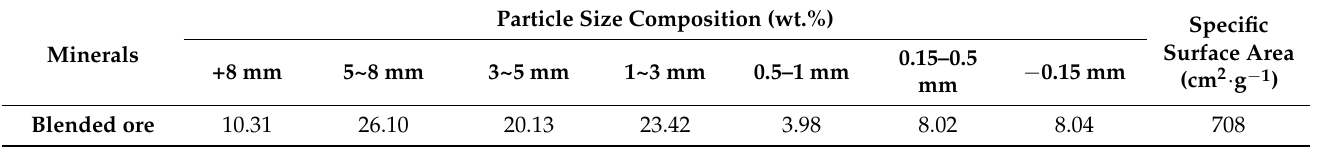
Table 3. Particle size composition of Blended